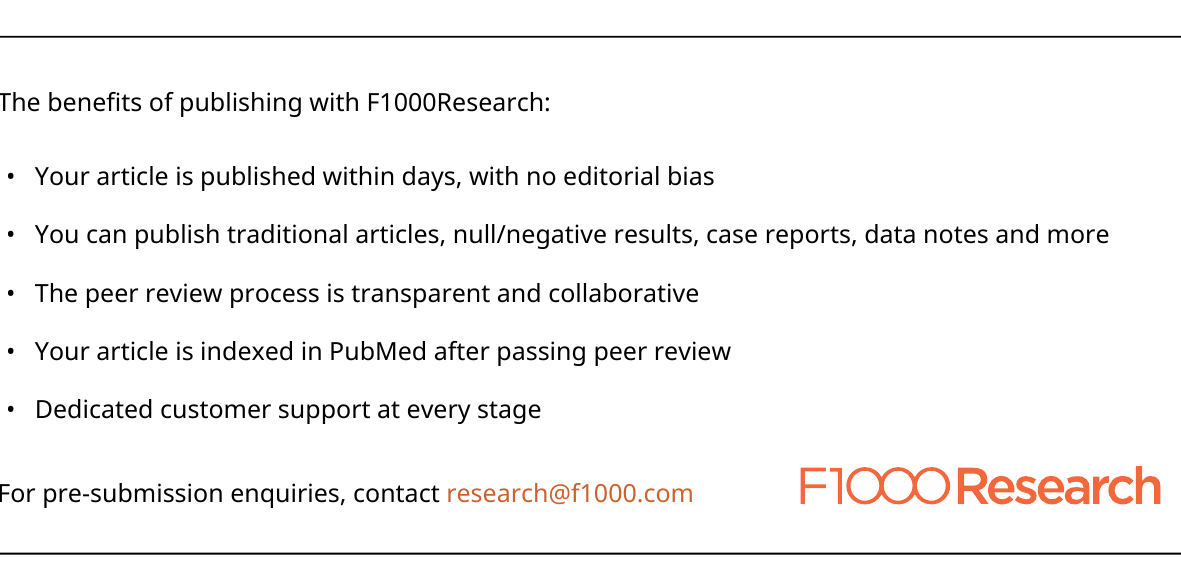
- Figure 1A: Please indicate top/bottom fractions and provide some information of the density at least of the peak fractions. Please mention in the legend how much of the total fractions was subjected to the gel. - Figure 1B: Please indicate the load. Are the membranes enriched compared to the glycosomal fraction? Please also provide more details on the experimental approach in the methods section, like volumes used for resuspension, fractions loaded on the gel,